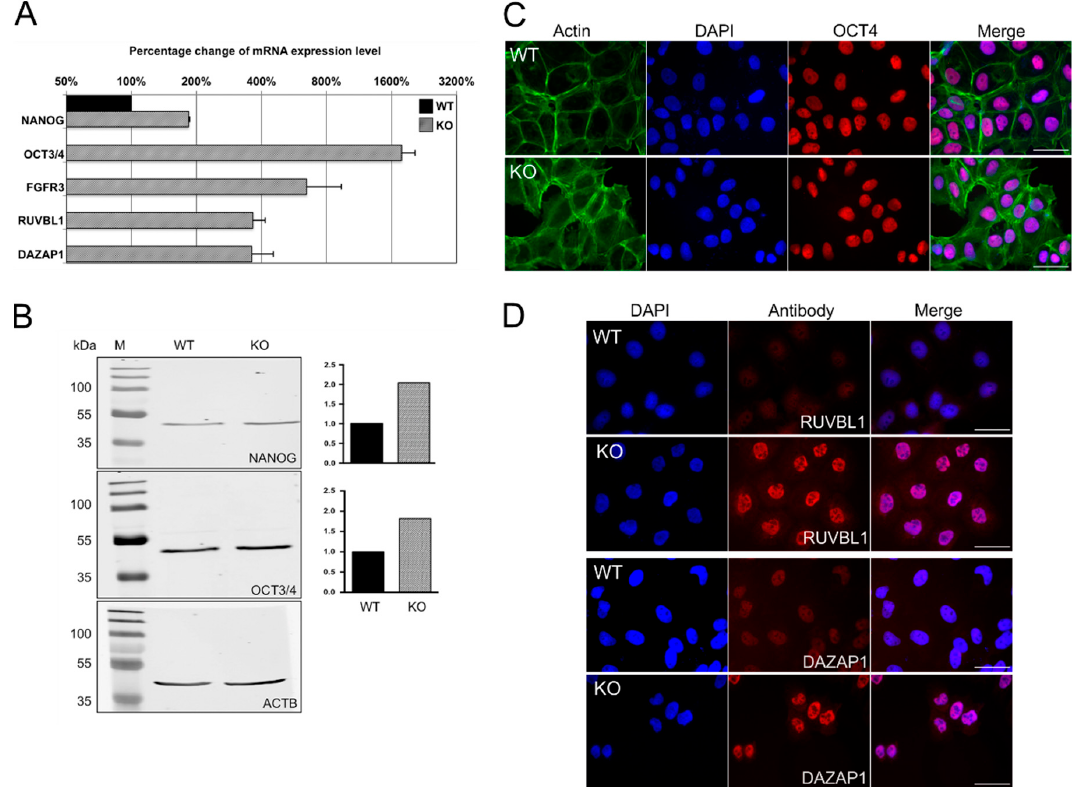
Figure 7. Increased expression of stem cell markers in TCam-2 cells deficient in FLNA (KO) compared to wildtype (WT) cells. ( A ) Deletion of FLNA causes increased levels of mRNAs encoding the embryonic stem cell markers NANOG, OCT3/4 and FGFR3, as well as RUVBL1 and DAZAP1. mRNA data are depicted as percentage change of mRNA expression levels of TCam-2 WT cells (WT, black bar = 100%) compared to FLNA-deficient cells (KO, gray bars). Samples were pipetted in duplicate and qPCR runs were performed twice to generate mean values of two clones; + SEM. ( B ) Western blot analysis of NANOG and OCT3/4. The quantification of protein normalized to levels of ACTB confirmed increased protein levels for both markers in FLNA-KO cells. Quantification of the Western blot shown is presented on the right. ( C ) Immunofluorescence microscopy of OCT4 in TCam-2 WT and FLNA-KO cells. ( D ) Immunofluorescence localization of RUVBL1 and DAZAP1 in TCam-2 WT and FLNA-KO cells. Scale bars: 50 µm.